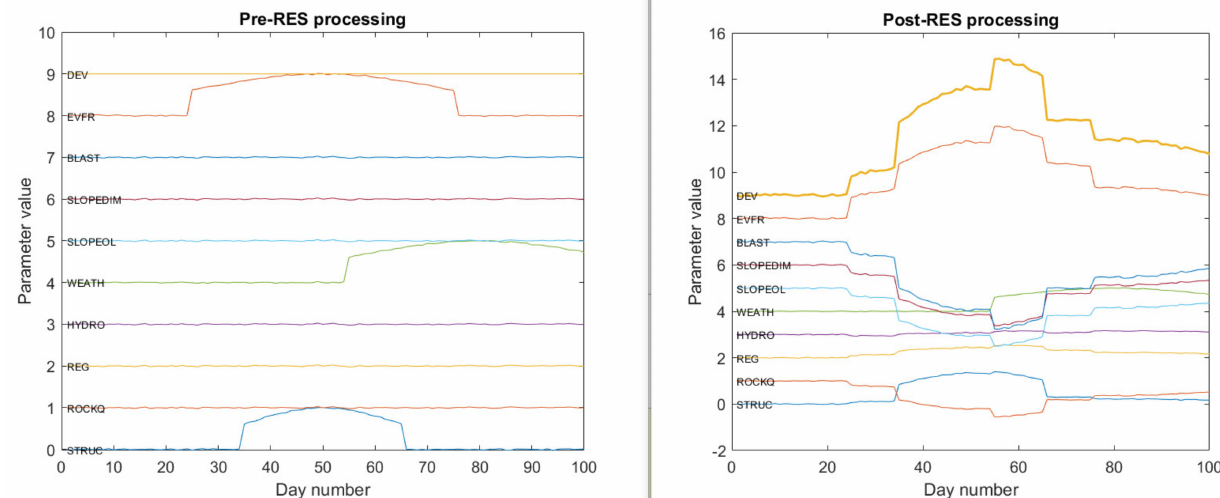
Figure 9. Simulated production data for the first 100 days (bold orange trace on right) and input RES parameters (non-bold traces) as a function of highwall strike distance. Traces have vertical offsets for clarity. The left figure shows inputs (uncoupled), and the right shows fully coupled outputs from the